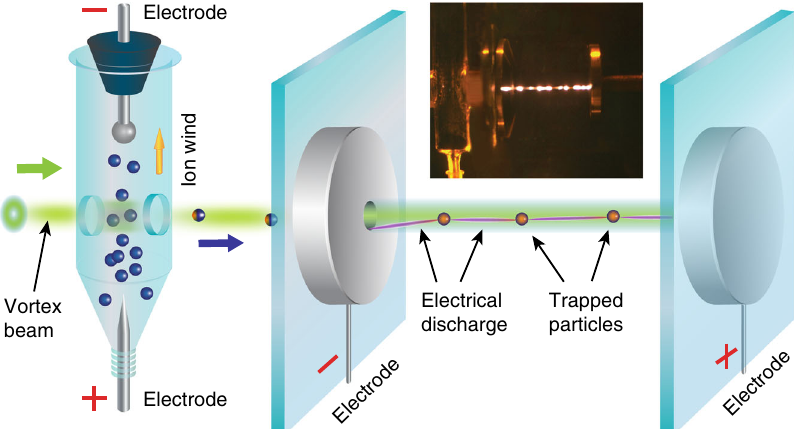
Fig. 3 Experimental con fi guration and principles of optical vortex beam for discharge control and guidance. At fi rst, microparticles are prepared and placed in an enclosed container with vertically aligned electrodes (left). An applied electric fi eld through the container lifts the particles by electrostatic forces. Some of the lifted particles cross the hollow core doughnut-shaped CW laser beam and get trapped in it. The vortex laser beam is guides particles in the mid-air: particles from a container are transported into a parallel plate chamber through a hole in one of the electrodes. In addition, particles are heated by the same laser beam thus creating a thermal channel between the electrodes that results in a subthreshold electrical breakdown. The inset shows a photograph of the experimental setup with particles trapped in the beam. Channelling of the discharge along the beam path is clearly observed (Supplementary Movie 6).